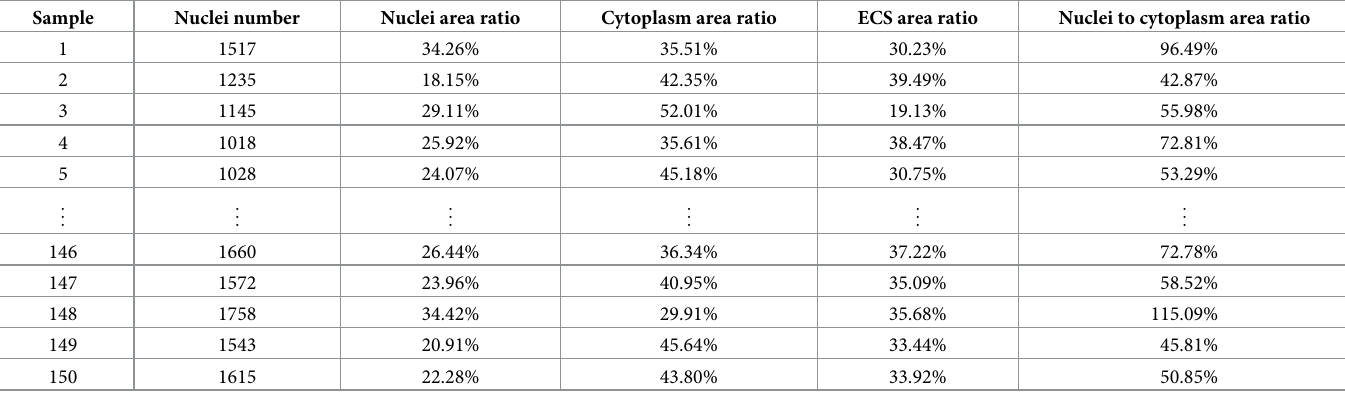
Table 8. High grade meningioma features.